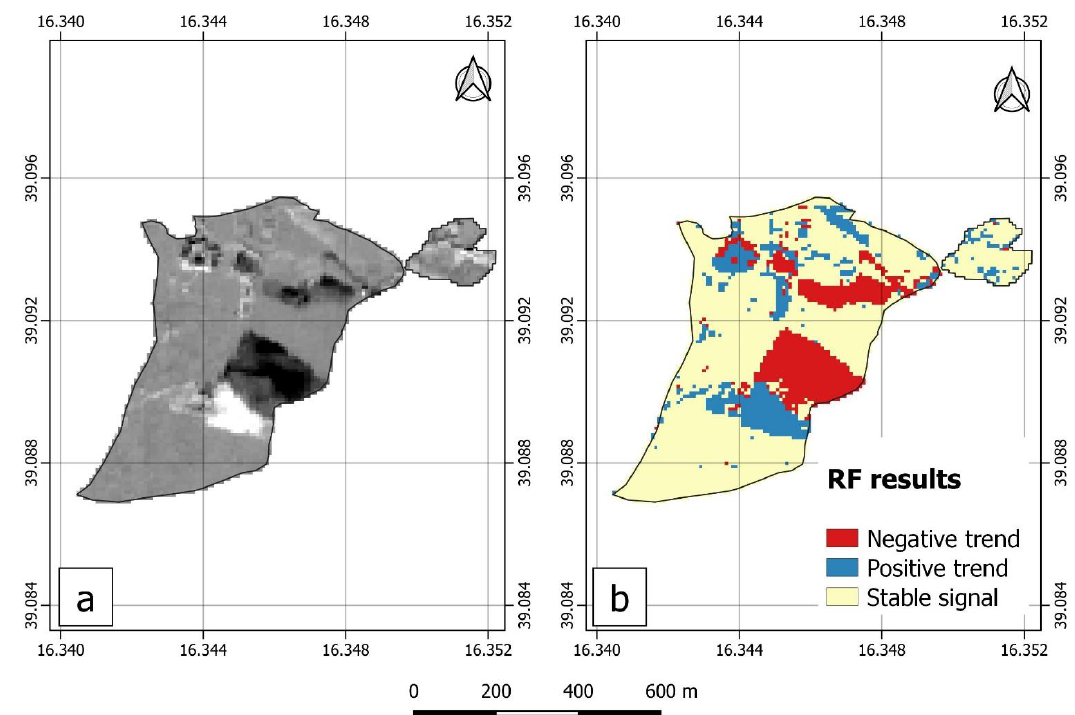
Figure 8. Comparison between ( a ) single-band image of slope (scales): positive values are light, negative values are dark, grey represents values very close to 0; and ( b ) RF results. LR provided good results as a method to identify changes in time series. In more detail, the following various types of land-use/land-cover change were identified in the analyzed case studies: (i) woodland felling, (ii) remaking of paths and roads, and (ii) tran- sition from wooded area to cultivated field. All of these changes were confirmed by the high multi-temporal resolution offered by Google Earth (Figures 9 and 10).